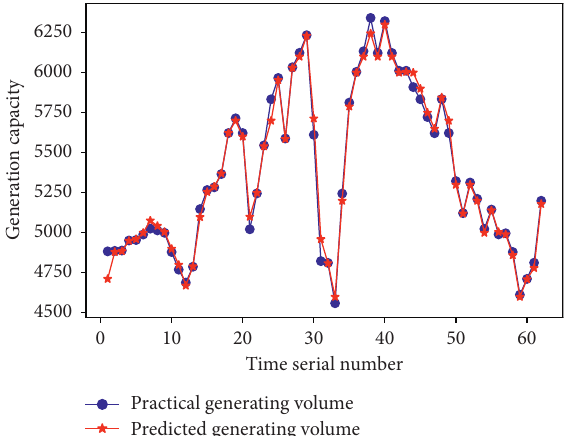
Figure 9: Comparison of photovoltaic power generation forecast from July 1 to August 31.